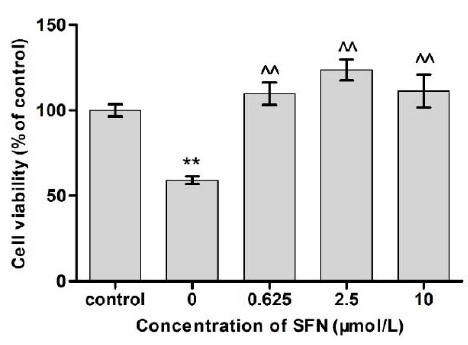
Figure 3. Effects of SFN at different concentrations on the viability of Cd ‐ exposed TM4 cells (12.5 μ mol/L). ** p < 0.01 as compared to the control group, ^^ p < 0.01 as compared to the Cd group.